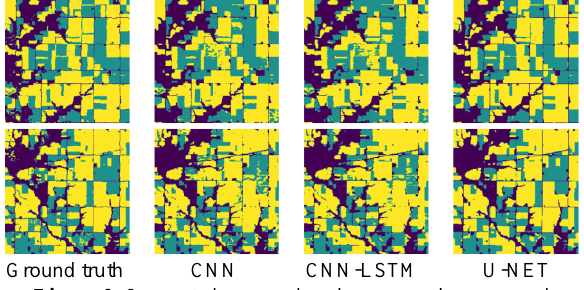
Figure 9. Generated corn and soybean maps by proposed